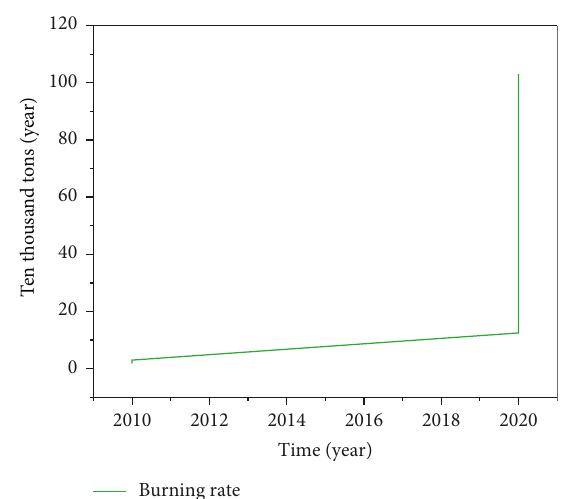
Figure 3: Waste incineration rate cannot be